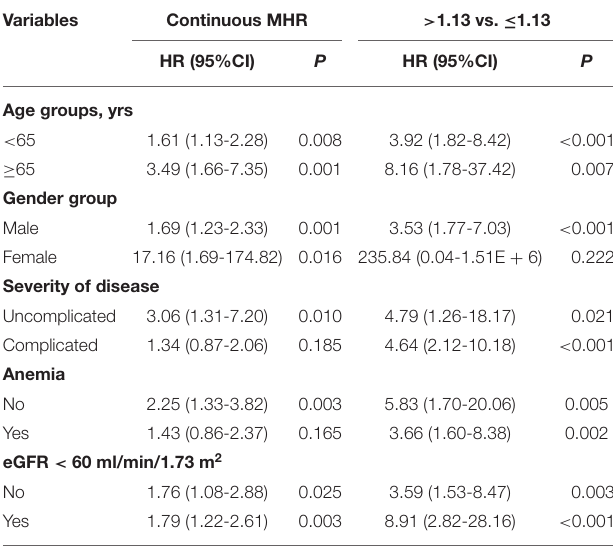
FIGURE 4 | ROC curves of MHR, monocyte, and HDL-C for long-term mortality. HDL-C, high-density lipoprotein cholesterol. MHR, monocyte to high-density lipoprotein ratio.